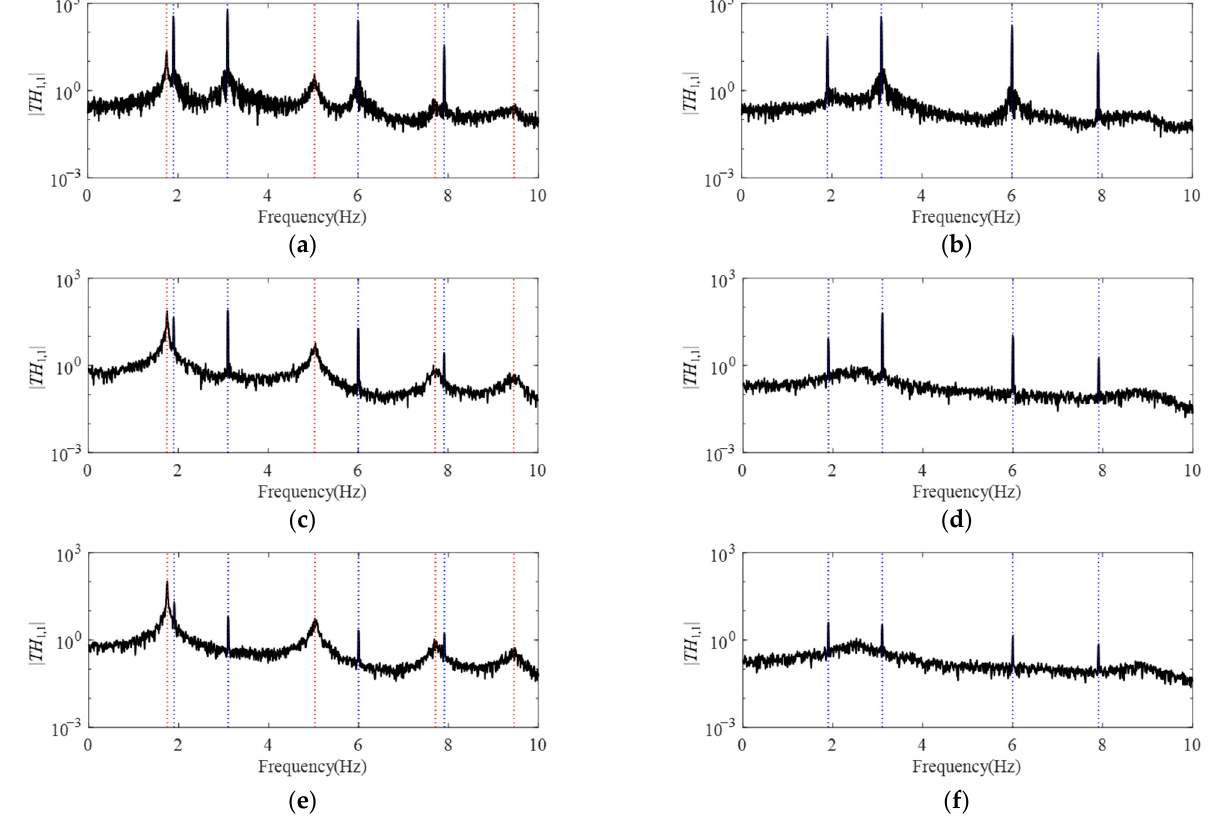
Figure 13. Schematic diagram of the pumping unit of a medium-sized pumping station.